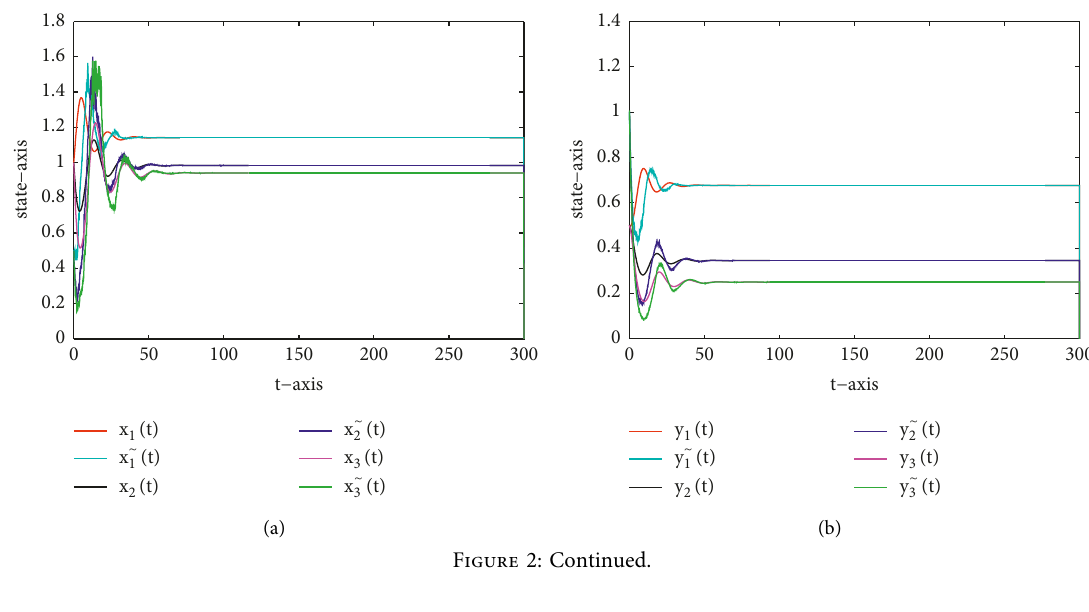
Figure 1: The global asymptotical stability of E ∗ ( x ∗ , y ∗ ) , where x ( t ) and x ∼ represent the intensities of predator of (2) and (21), respectively. (a) The time series graph of prey and predator of (2). (b) The time series graph of prey and predator of